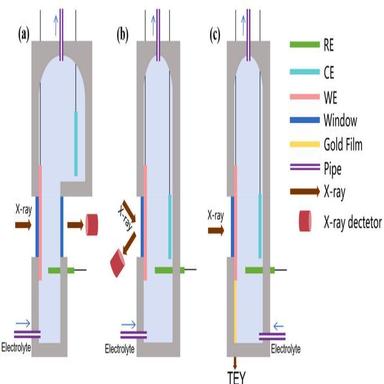
Schemes of in-situ XAS electrochemical cells for (a) Transmission mode, (b) FY mode and (c) TEY mode. WE: working electrode. RE: reference electrode. CE: counter electrode.